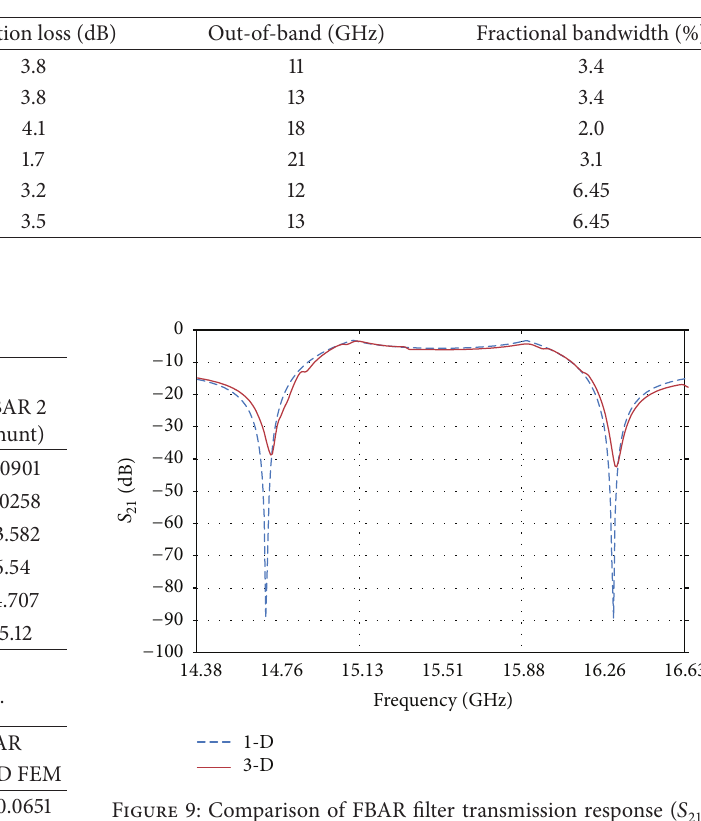
Table 3: Comparison of FBAR filter characteristics.